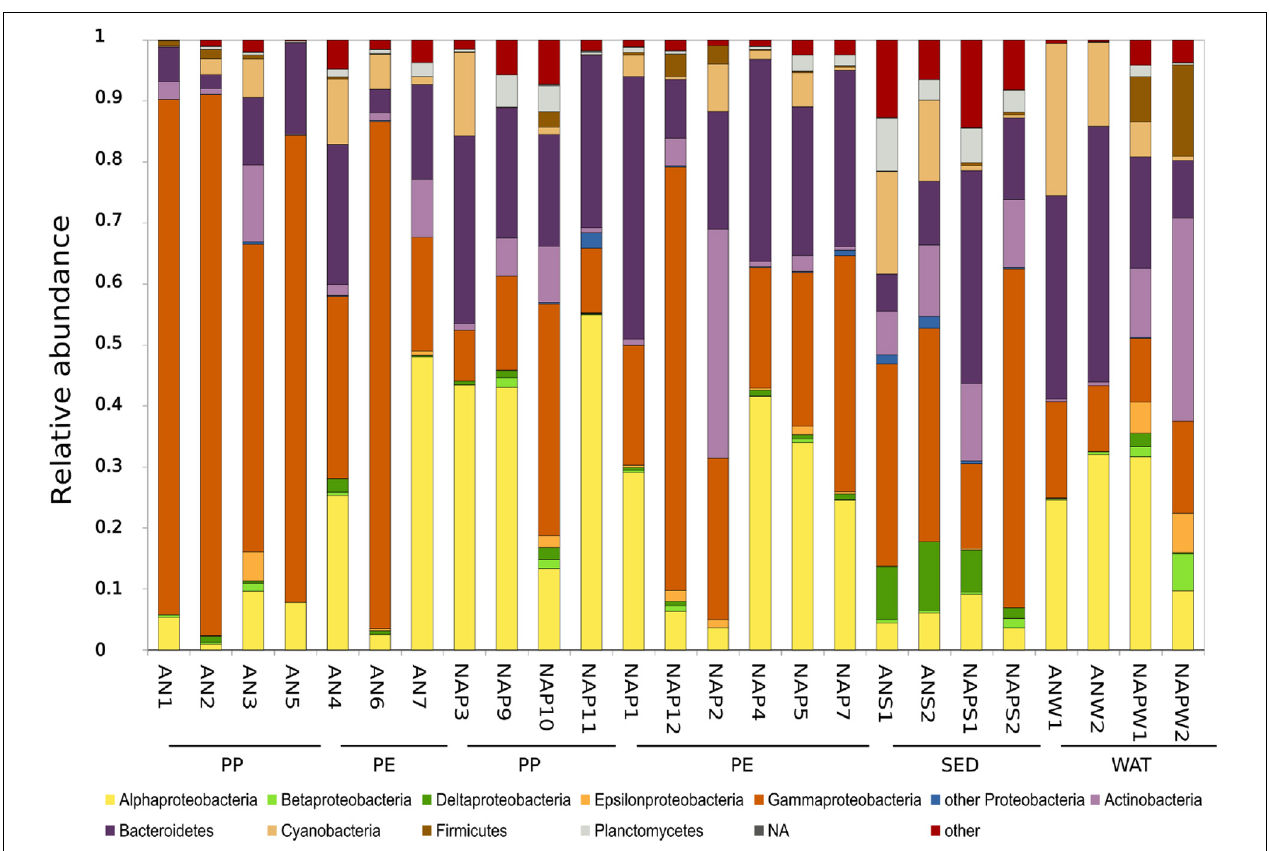
FIGURE 3 | Prokaryotic community composition (as%) at the Phylum level (Class level for Proteobacteria only). Groups with an average relative abundance across all samples < 1% were aggregated into the group reported as “Others”. “Unassigned” includes all those reads that did not match any known taxonomy. PP, polypropylene; PE, polyethylene; SED, sediment; WAT, seawater; NA, not